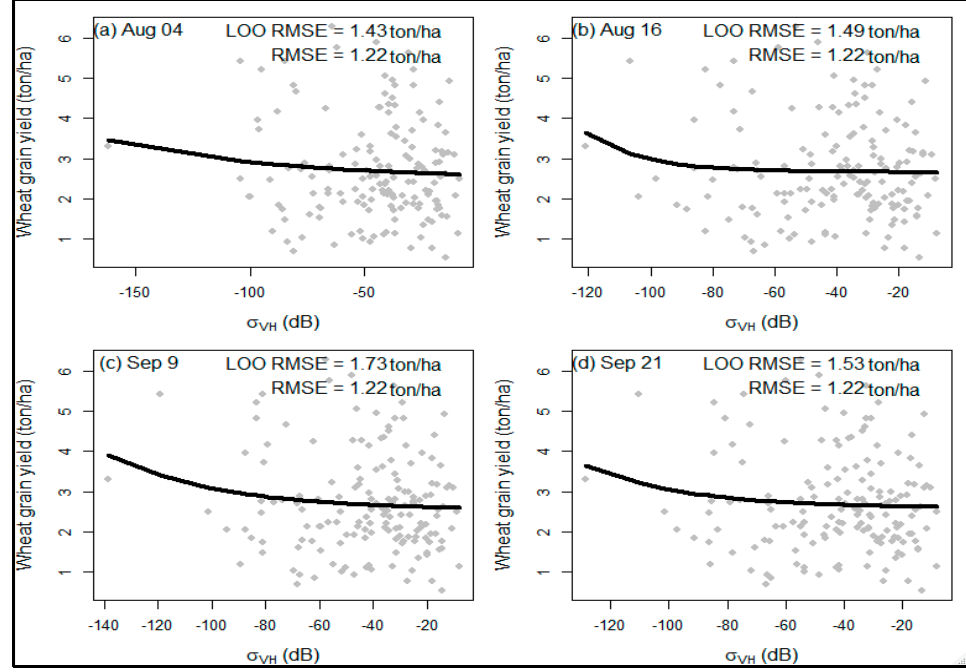
Figure 3. Scatter plots of SAR indices of single growth stage ( x − axis) vs. grain yield ( y − axis) for tillering and grain ‐ filling stage.